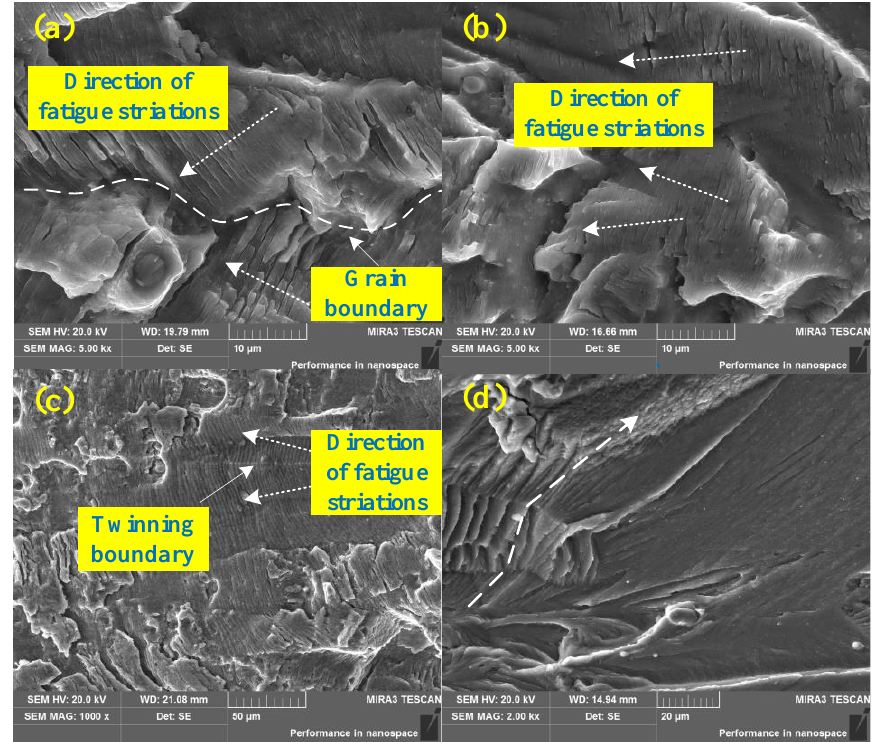
Figure 9. SEM images of different orientations in the stable crack propagation zone: ( a , b ) fatigue fringes on adjacent grains with different orientations; ( c ) twinning and fatigue fringes on both sides; ( d ) “Z”-shaped crack.